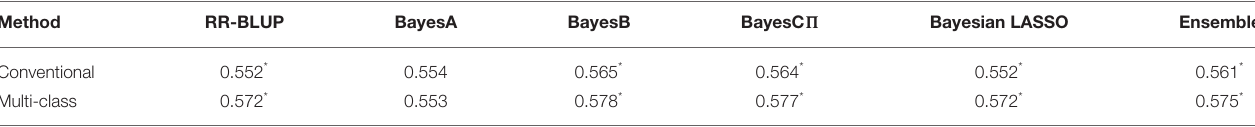
found between multi-class Bayesian Alphabet and conventional Bayesian Alphabet with RR-BLUP, BayesB, BayesC π Bayesian LASSO, and ensemble approach, respectively (p < 0.1).